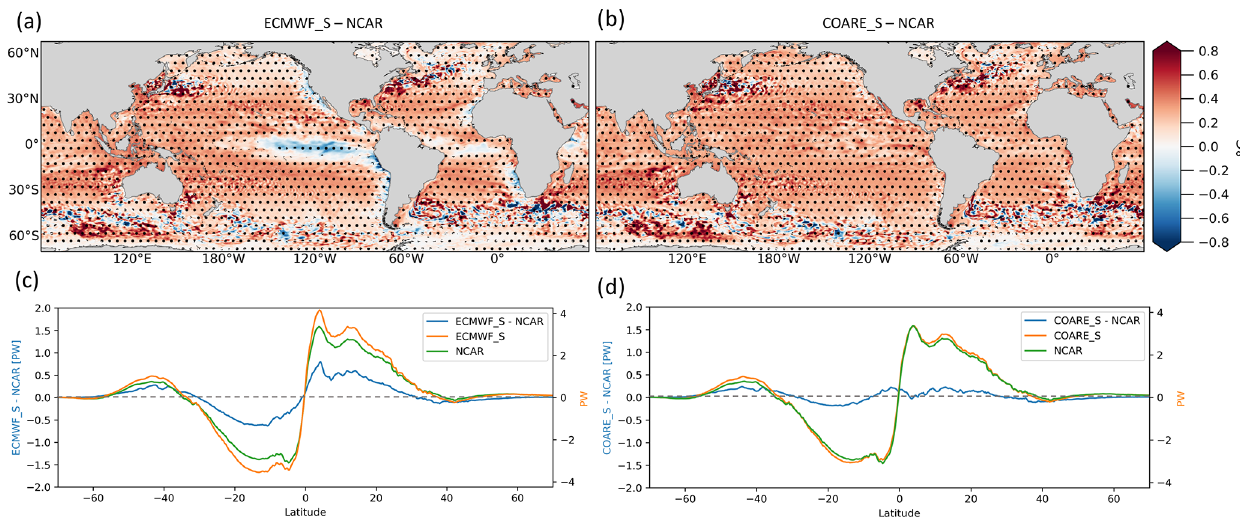
Figure 4. Annual mean SST differences between (a) ECMWF_S − NCAR and (b) COARE_S − NCAR . Global meridional heat transport computed in the upper 100m of the ocean for (c) ECMWF_S and NCAR and their differences; and for (d) COARE_S and NCAR and their differences. Right (left) y axes represent the MHT for single experiments (MHT difference). Hatching indicates significant values (95% confidence